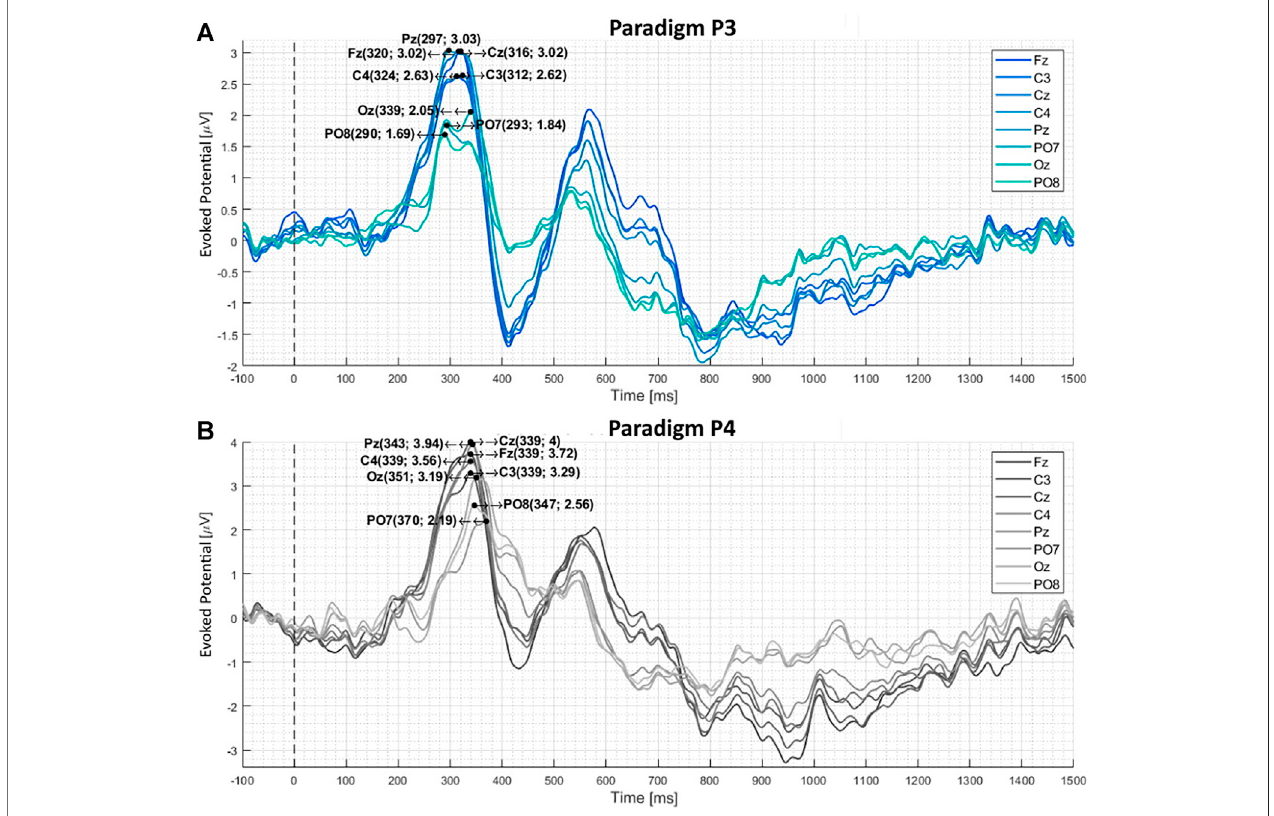
FIGURE5| Thecalculateddifferencebetweentargetandnon-targetstimuliaveragedover21subjects (A) and (B) depictsthevisualevokedpotentialproducedby paradigms P4 and P3, respectively. These two paradigms had familiar faces as targets and unfamiliar faces as non-targets. The black dotted line marks the stimulus presentation. The P300 latency and amplitude are noted in the brackets [(ms), ( μ V )].